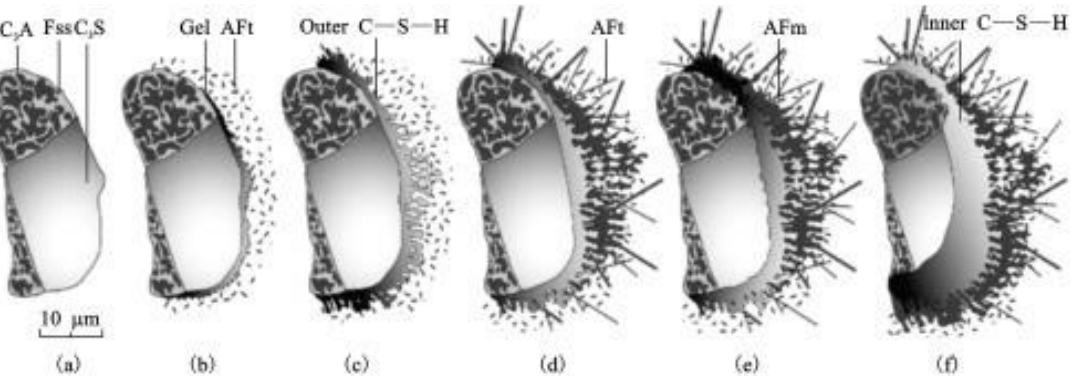
Figure 6. Image showing the mechanism of flocculation: ( a ) unhydrated section of polymineralic grain (scale of interstitial phase is slightly exaggerated), ( b ) after 10 min, ( c ) after 10 h, ( d ) after 18 h, ( e ) after 1-3 days, ( f ) after 14 days [83].